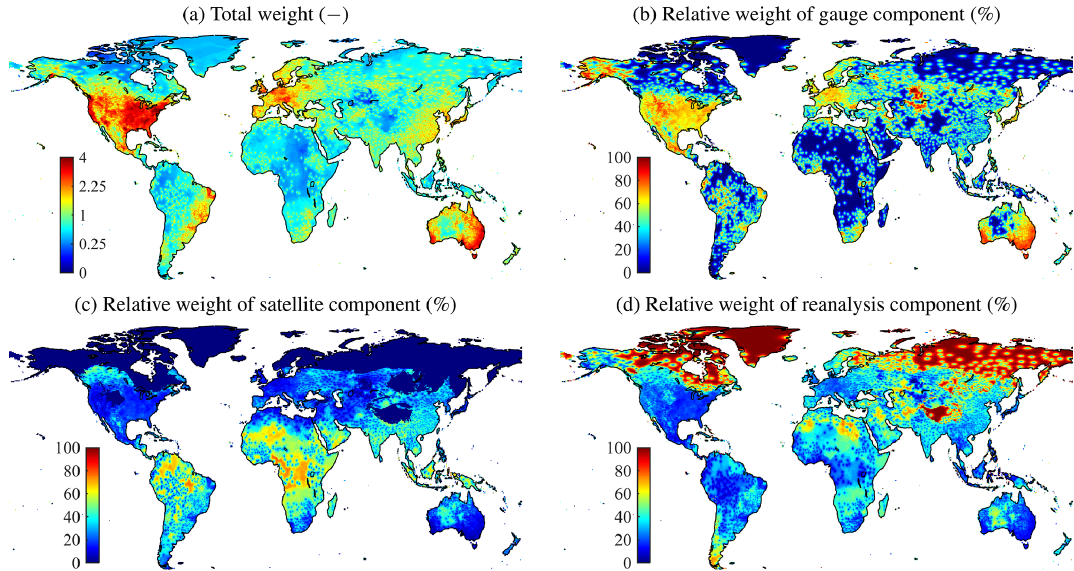
Figure 6. Map (a) shows the sum of the gauge weight (see Eq. 7) and the satellite and reanalysis weights (derived from 3-day correlation coefficients at surrounding gauges) used during merging stage 3 (see Fig. 1) at the daily timescale on an arbitrarily chosen day (25 April 2006; note the non-linear color scale). The contributions of the gauge, satellite, and reanalysis components to the total weight on the same day are shown in (b) – (d) ,